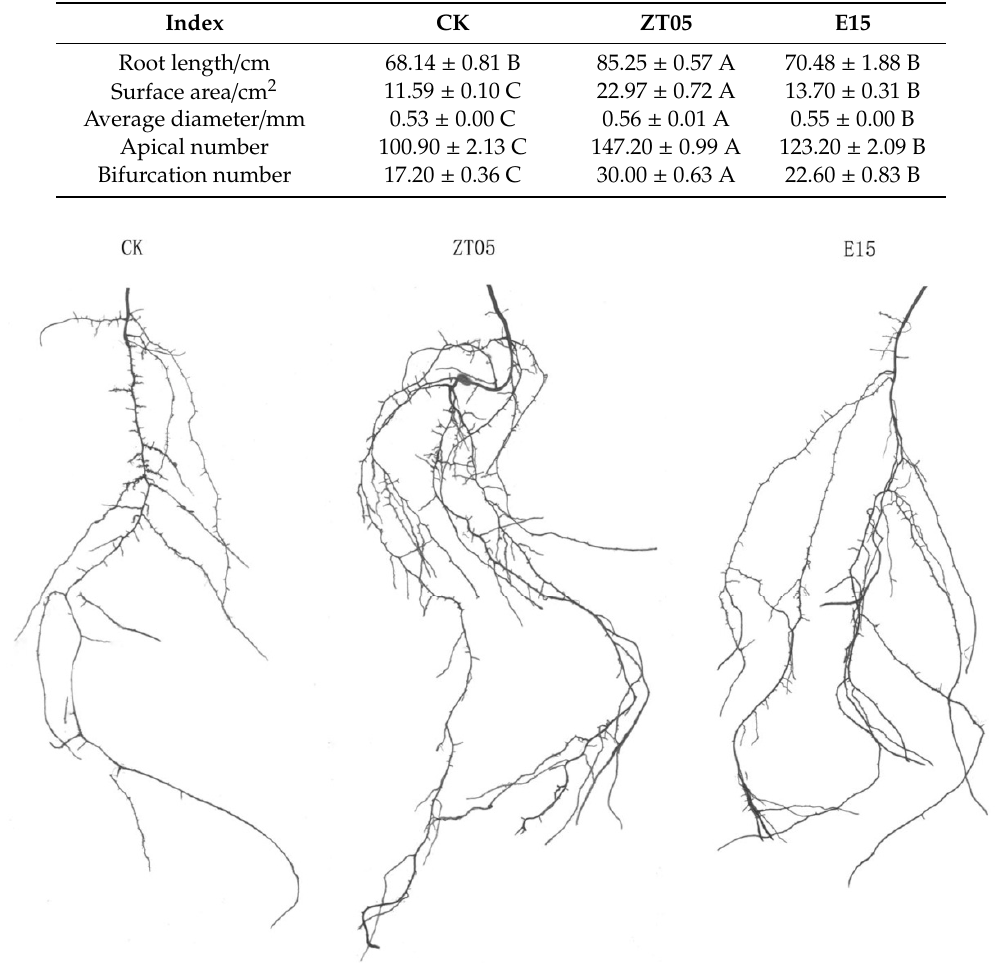
Table 1. Effects of Trichoderma inoculation on seedling root structure. CK: inoculation with PD blank culture medium. ZT05: single inoculation with T. virens ZT05. E15: single inoculation with T. harzianum E15. Different letters in the columns indicate significant differences ( p < 0.05), according to Duncan’s new multiple range test.